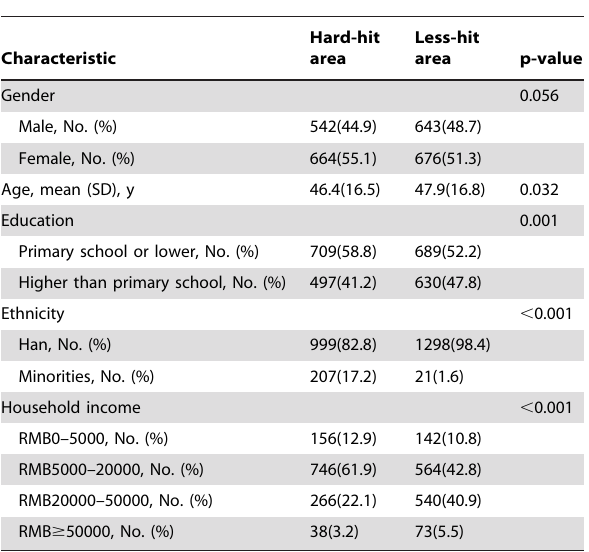
Table 1. Demographic characteristics of the populations of hart-hit and less-hit areas, Sichuan Province, China 3 years after Wenchuan earthquake.